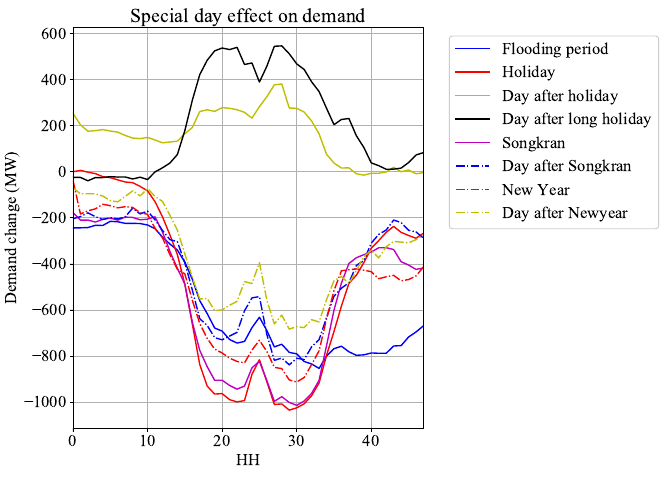
Figure 3. Demand variation at individual half-hour for special